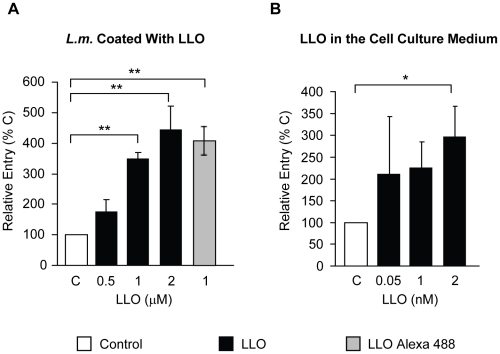
Direct and dose-dependent role of LLO in L. monocytogenes entry.(A) LLO-deficient L. monocytogenes (Δhly, strain DPL2161, L.m.) treated with 1 mM nickel (II) chloride coating buffer in the absence (C) or presence of LLO (black bars) or LLO Alexa 488 (grey bar) were used to infect HepG2 cells at 37°C for 30 min (MOI = 20). (B) HepG2 cells were infected with LLO-deficient L. monocytogenes (Δhly, DPL2161) at 37°C for 30 min (MOI = 20), in the absence (C) or in the presence of LLO added exogenously to the cell culture medium (black bars). In (A) and (B) bacterial entry was measured by fluorescence microscopy. The results were expressed relative to bacteria incubated with host cells in the absence of LLO (C) and were the mean ± SEM (n≥3).